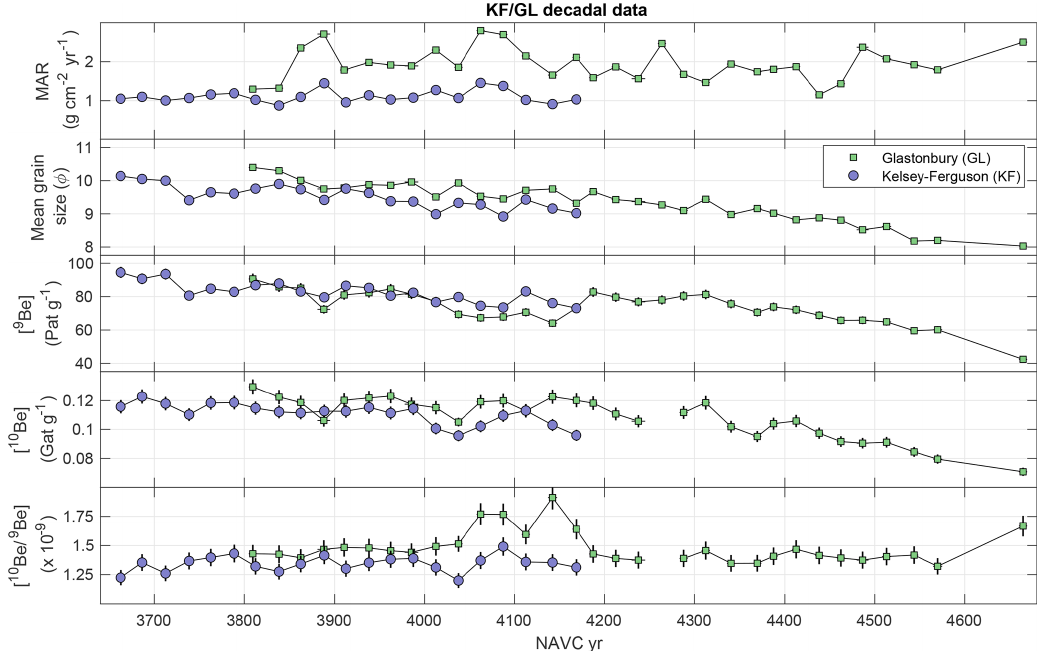
Figure 16. Sedimentological data and Be concentrations for decadal-resolution records from adjacent, overlapping sequences of glacial varves at Glastonbury (GL) and Kelsey–Ferguson